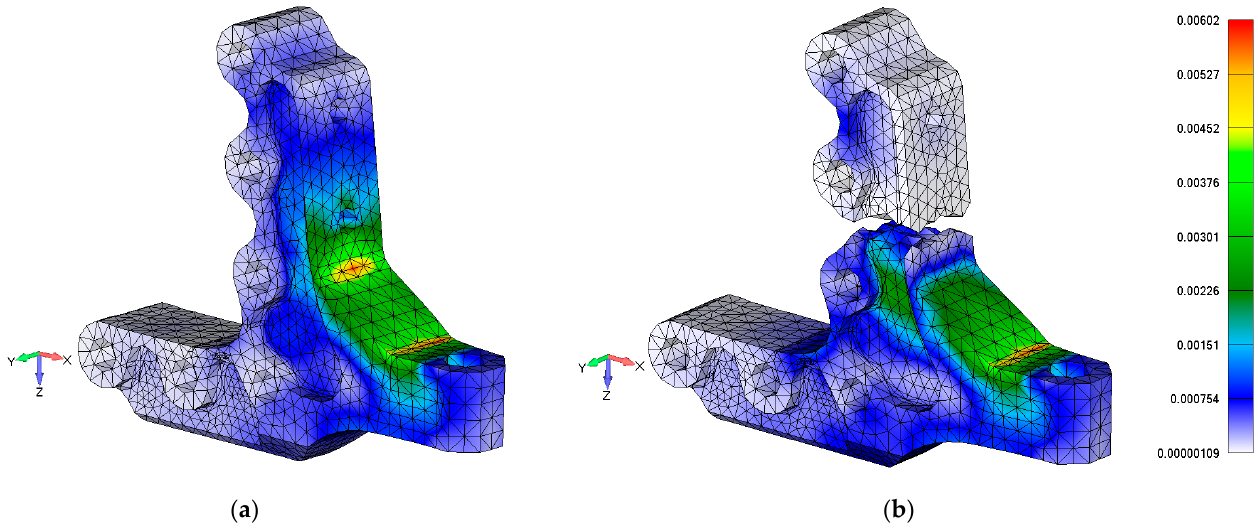
Figure 24. Comparison of principal strain contour map between FE simulation of the pristine stop fitting (a) and damaged stop fitting (b).